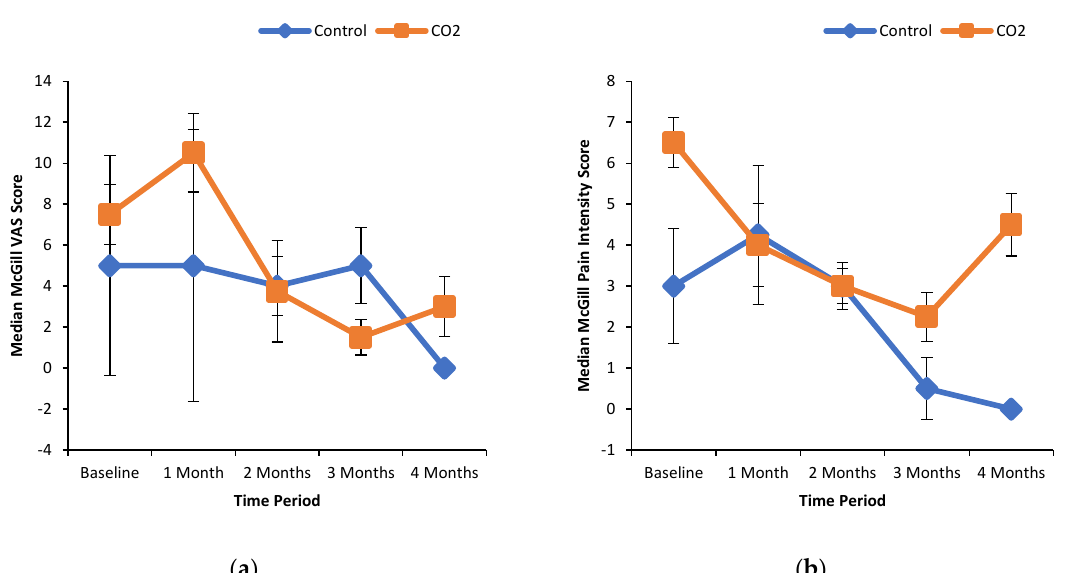
Figure 3. McGill VAS and pain intensity scores in patients treated with and without CO 2 -enriched water. The short form McGill Pain Questionnaire was used to measure the degree of pain ( a ) and degree of pain intensity ( b ) experienced by the study participants.